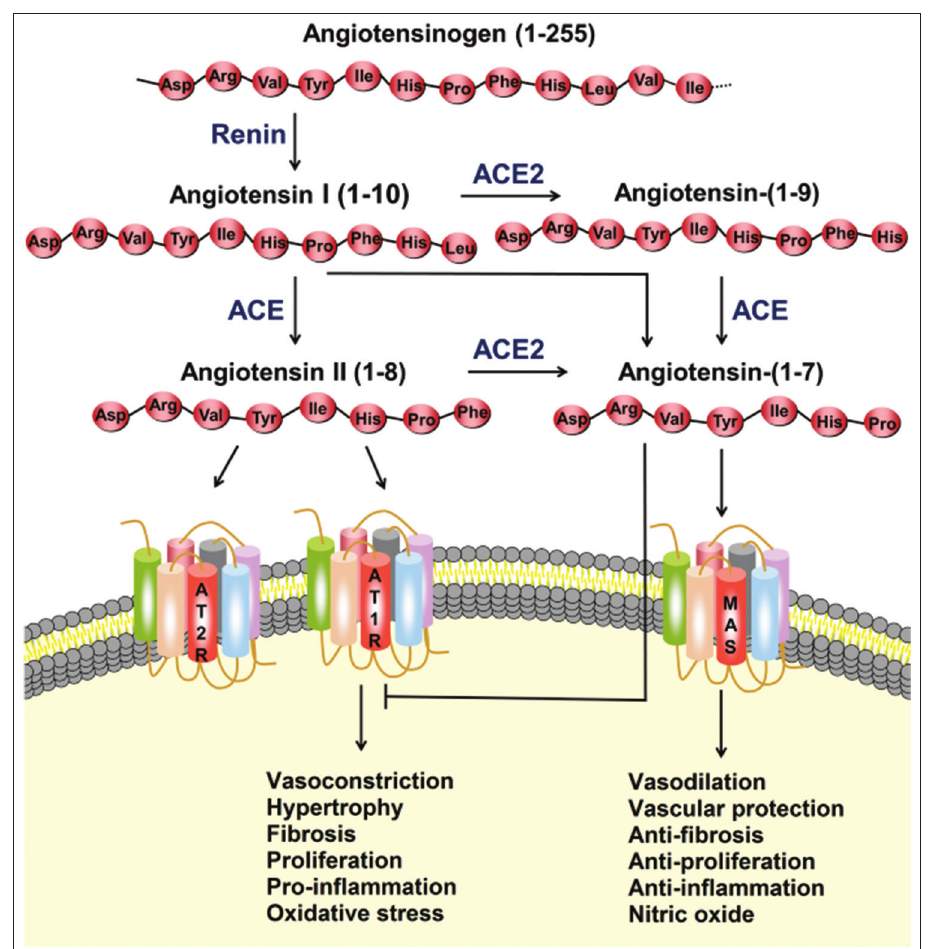
Figure-4: The structure of SARS-CoV-2 with different cell surface membrane